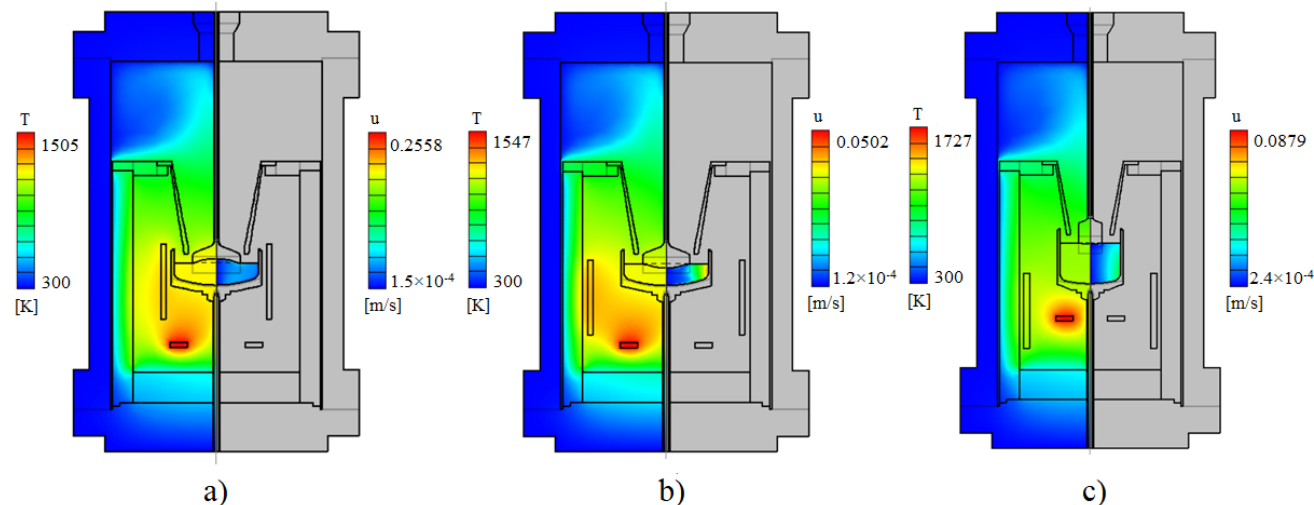
Figure 3. Examples of CFD results for the temperature T in the furnace and the melt velocity u for various furnace designs and growth recipes. The results correspond to the following inputs x 1 –x 13 :